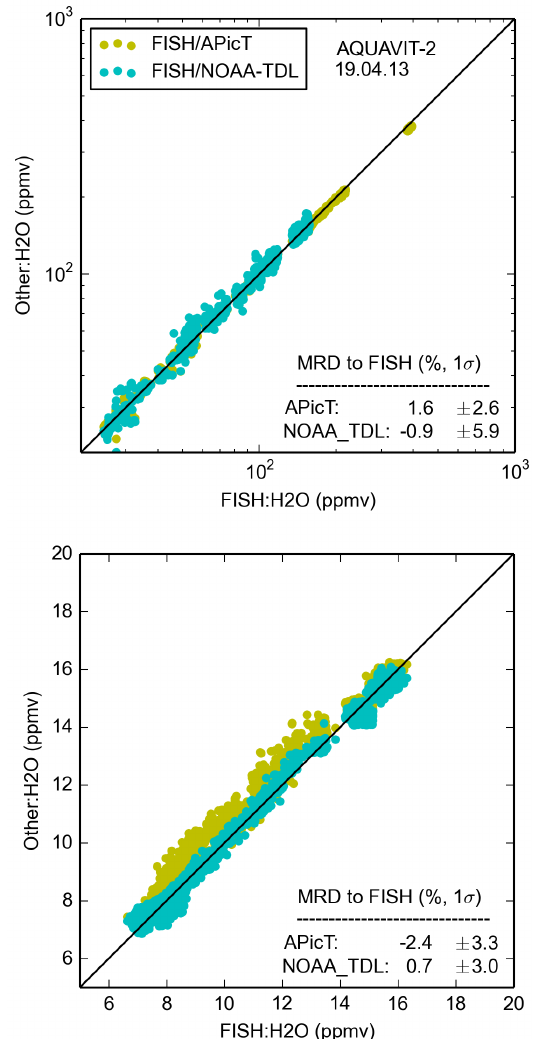
Figure 12. Scatterplot of WVMR during AquaVIT-2 (19.04.2012); top: WVMR 20–1000ppmv; bottom: zoom for WVMR 7–20ppmv. Mean relative deviation (MRD) to FISH is given for each individual instrument.